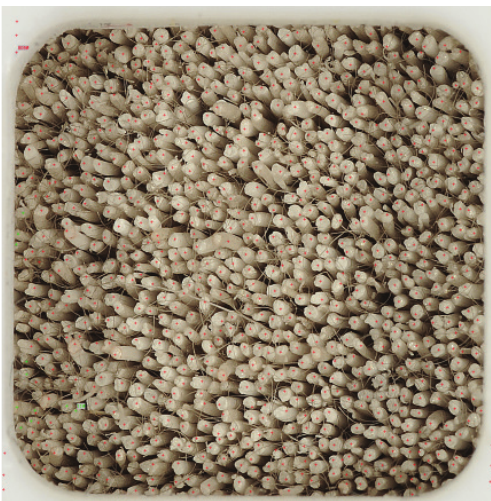
Figure 2. Example of a 1x1 cm sample of shorn fur viewed under the microscope when measuring the density of hairs. The figure shows winter pelage of a reindeer. Each hair is marked with a red cross.